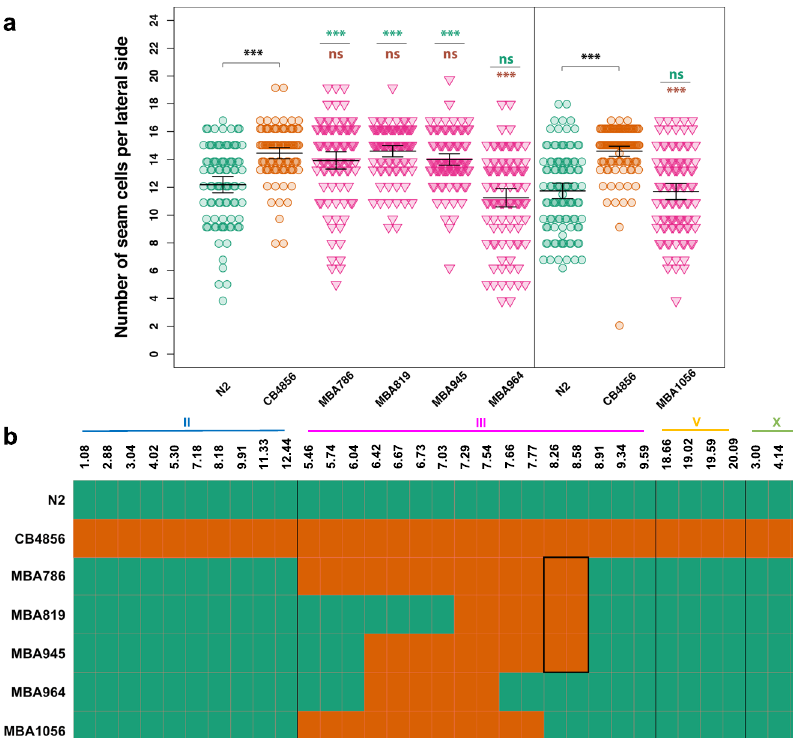
Fig. 5 Genotype-to-phenotype analysis of NILs carrying genomic fragments of chromosome III from CB4856. a Seam cell number in near isogenic lines containing various fragments of chromosome III from CB4856 in the egl-18(ga97) N2 background. Vertical black line in the graph distinguishes between two independent experiments. In both experiments, one-way ANOVA showed that SCN was signi fi cantly affected by the strain ( F (5, 556) = 26.58, p < 2.2 × 10 − 16 ; F (2, 313) = 43.31, p < 2.2 × 10 − 16 respectively, n ≥ 90 independent animals). Error bars indicate 95% con fi dence intervals around the mean and *** p < 0.0001 corresponds to signi fi cant differences by post hoc Tukey HSD compared with N2 (green) and CB4856 (orange) respectively. b Genotyping of NILs carrying genomic fragments of chromosome III from CB4856 using genetic markers. Green and orange tiles represent N2 and CB4856 genomes, respectively. Highlighted box in the middle indicates the genomic region that is shared in the NILs in which phenotype expressivity is converted from N2 to CB4856 levels. Source data are provided as a Source Data fi